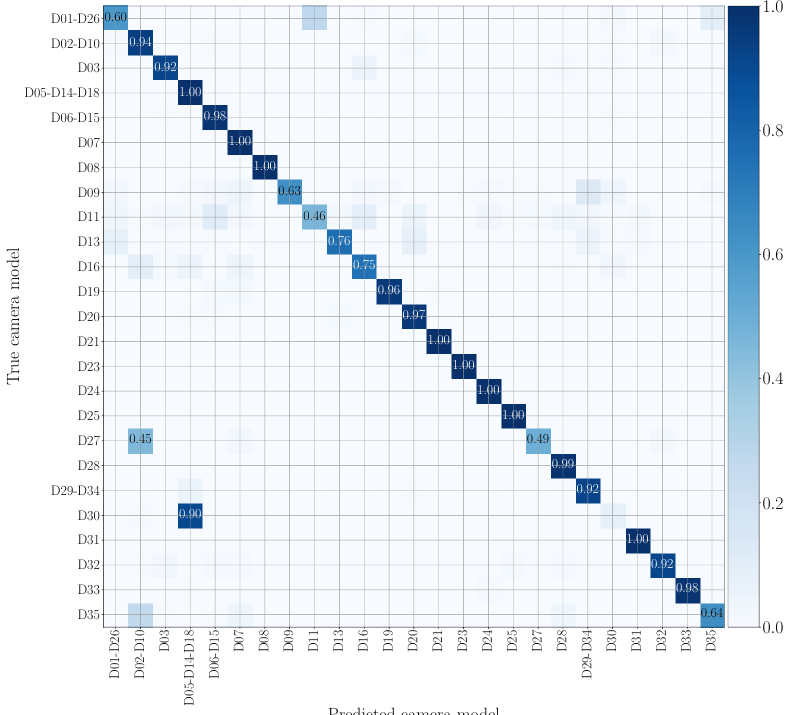
Figure 14. Confusion matrix achieved by multi-modal camera model identification exploiting Late Fusion EE 192 . We report results by training on the native video set and testing on YouTube videos, and we only show the numbers which exceed 0.3. Device nomenclature is that of